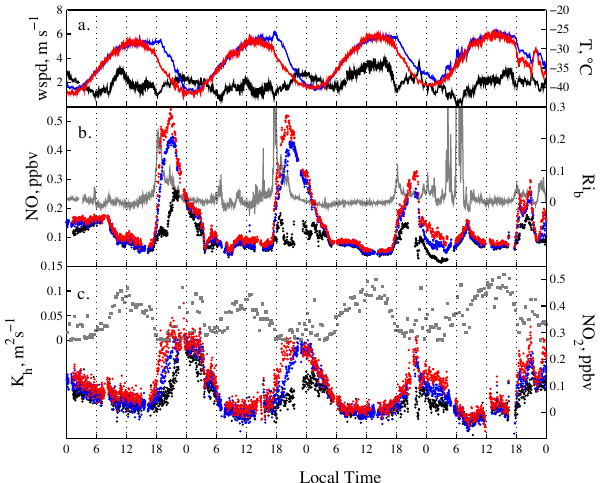
24:00 LT. Both increase in wind speed and change of wind